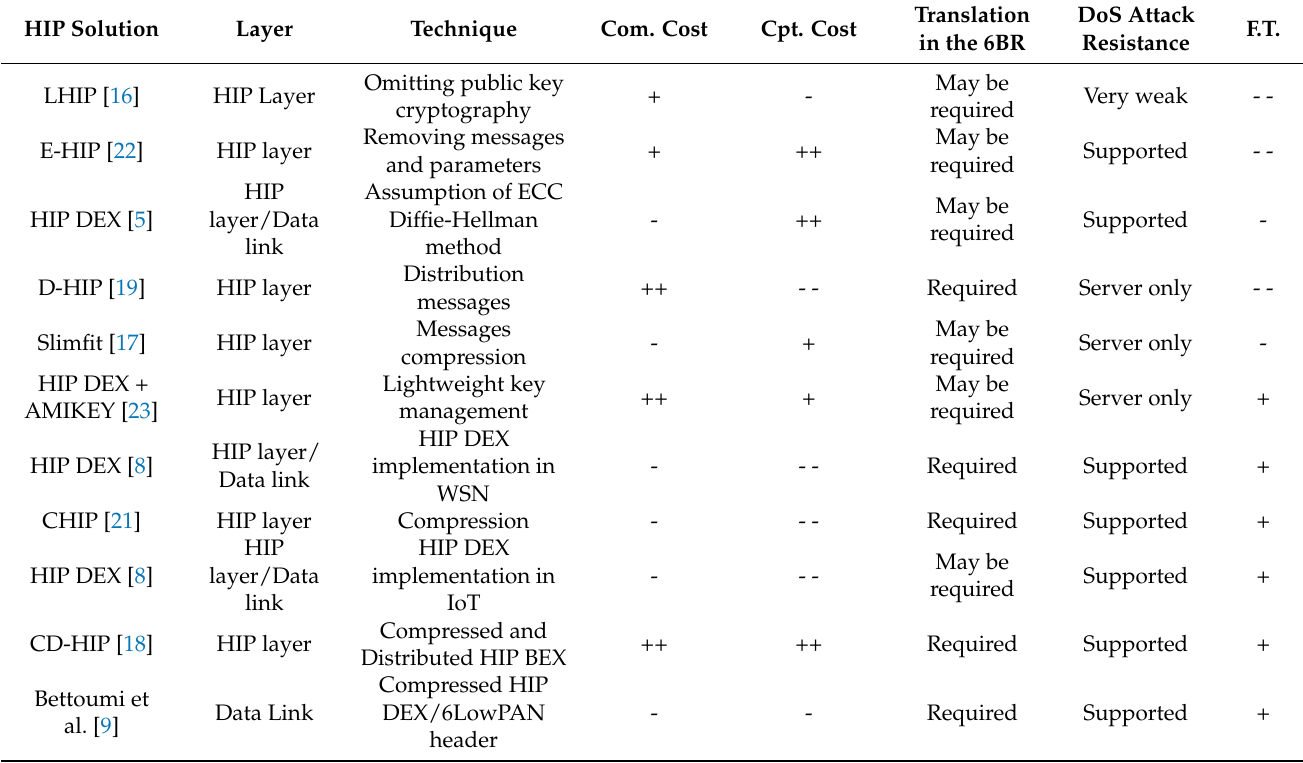
Table 1. Comparison between HIP based authentication solutions. (+) indicates high and (-) indicates low. Com.: Communi- cation, Cpt.: Computational, F.T.: Fault Toleranc. HIP Solution Technique Com. Cost Cpt. Cost